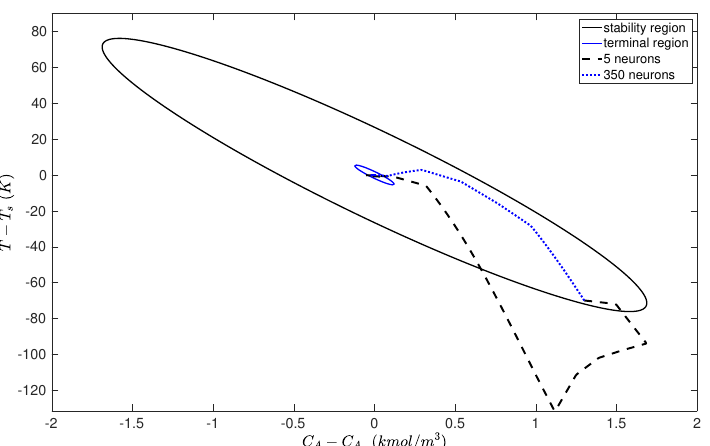
Figure 15. Closed-loop state trajectory under LMPC using two RNN models trained with differ- ent